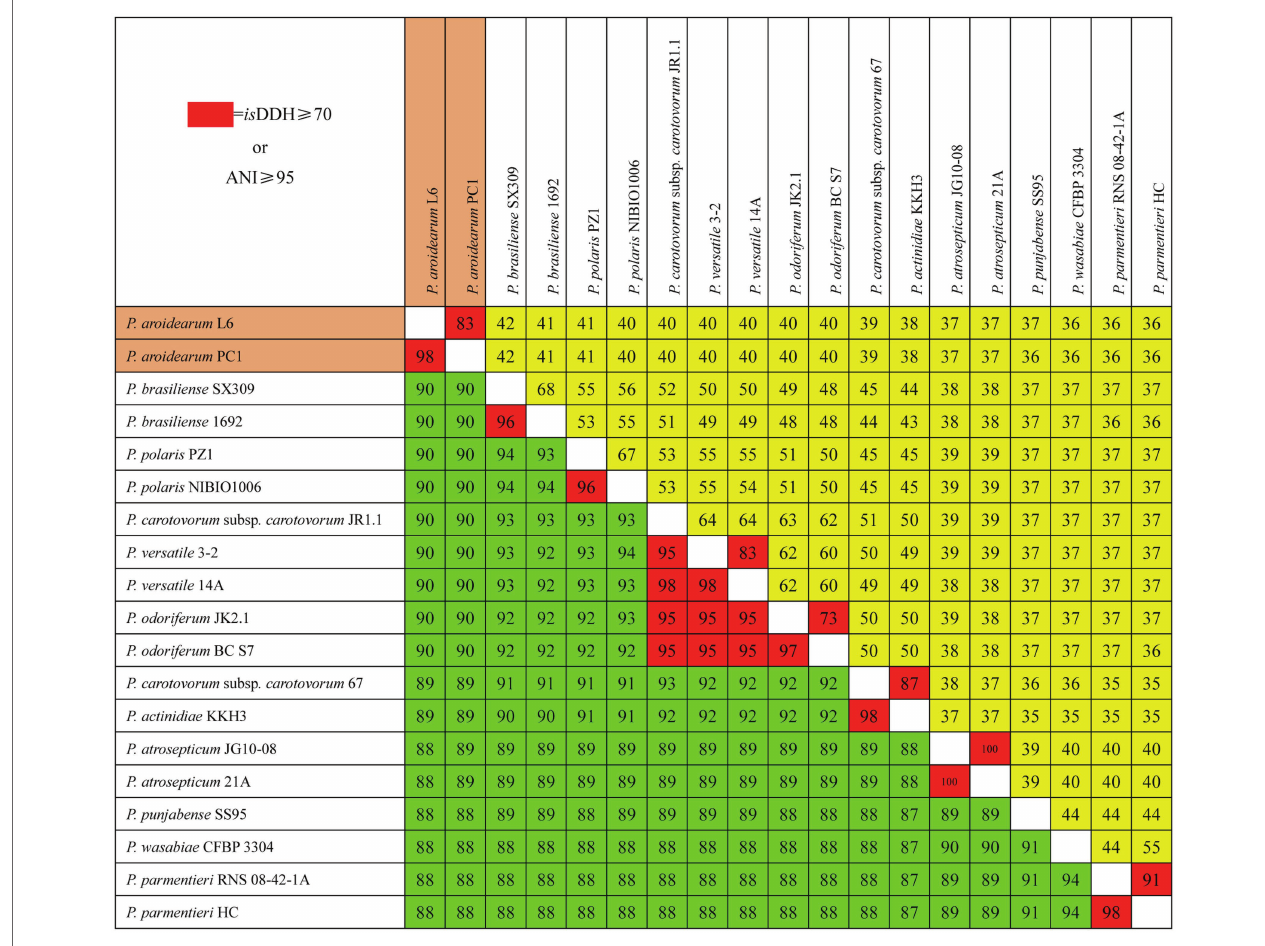
FIGURE 3 | Pairwise comparisons of is DDH and ANI values of Pectobacterium species. The upper triangle (yellow portion) displays is DDH values (%), and the lower triangle (green portion) displays ANI values (%). Boxes with is DDH ≥ 70% or ANI ≥ 95% are colored